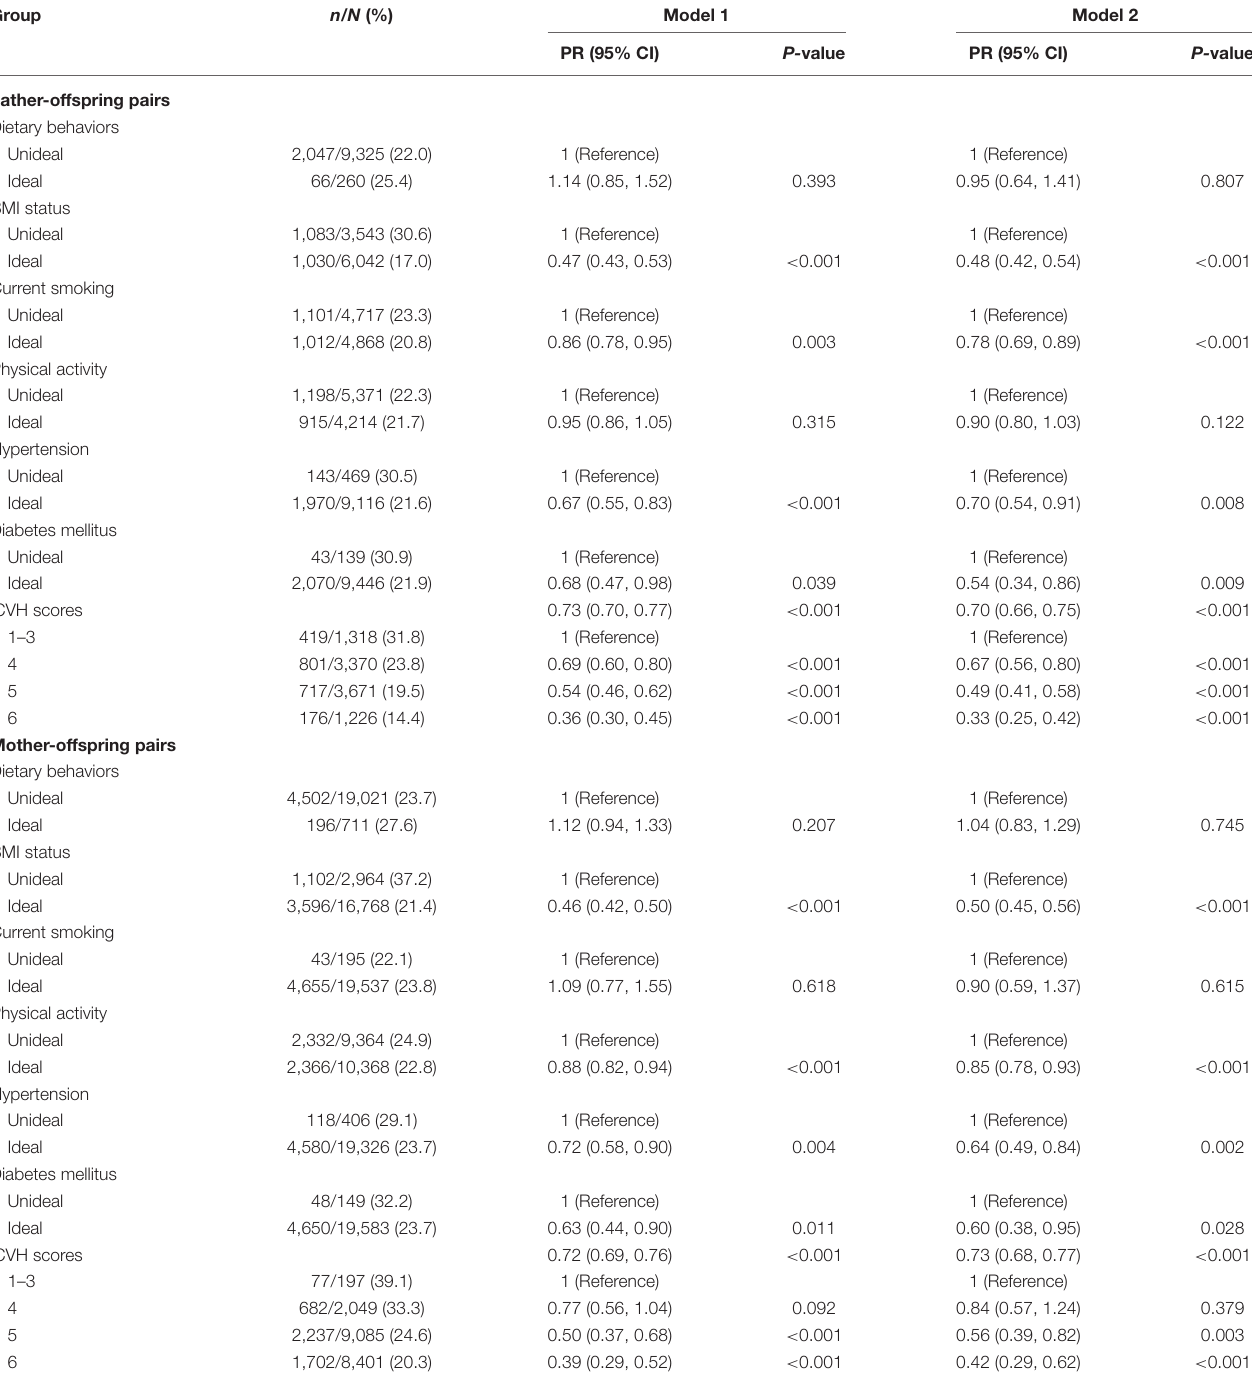
TABLE 3 | Multilevel mixed-effect models for the association between parental individual and combined iCVH factors and the prevalence of offspring overweight and obesity. Group n / N (%) Model 1 Model 2